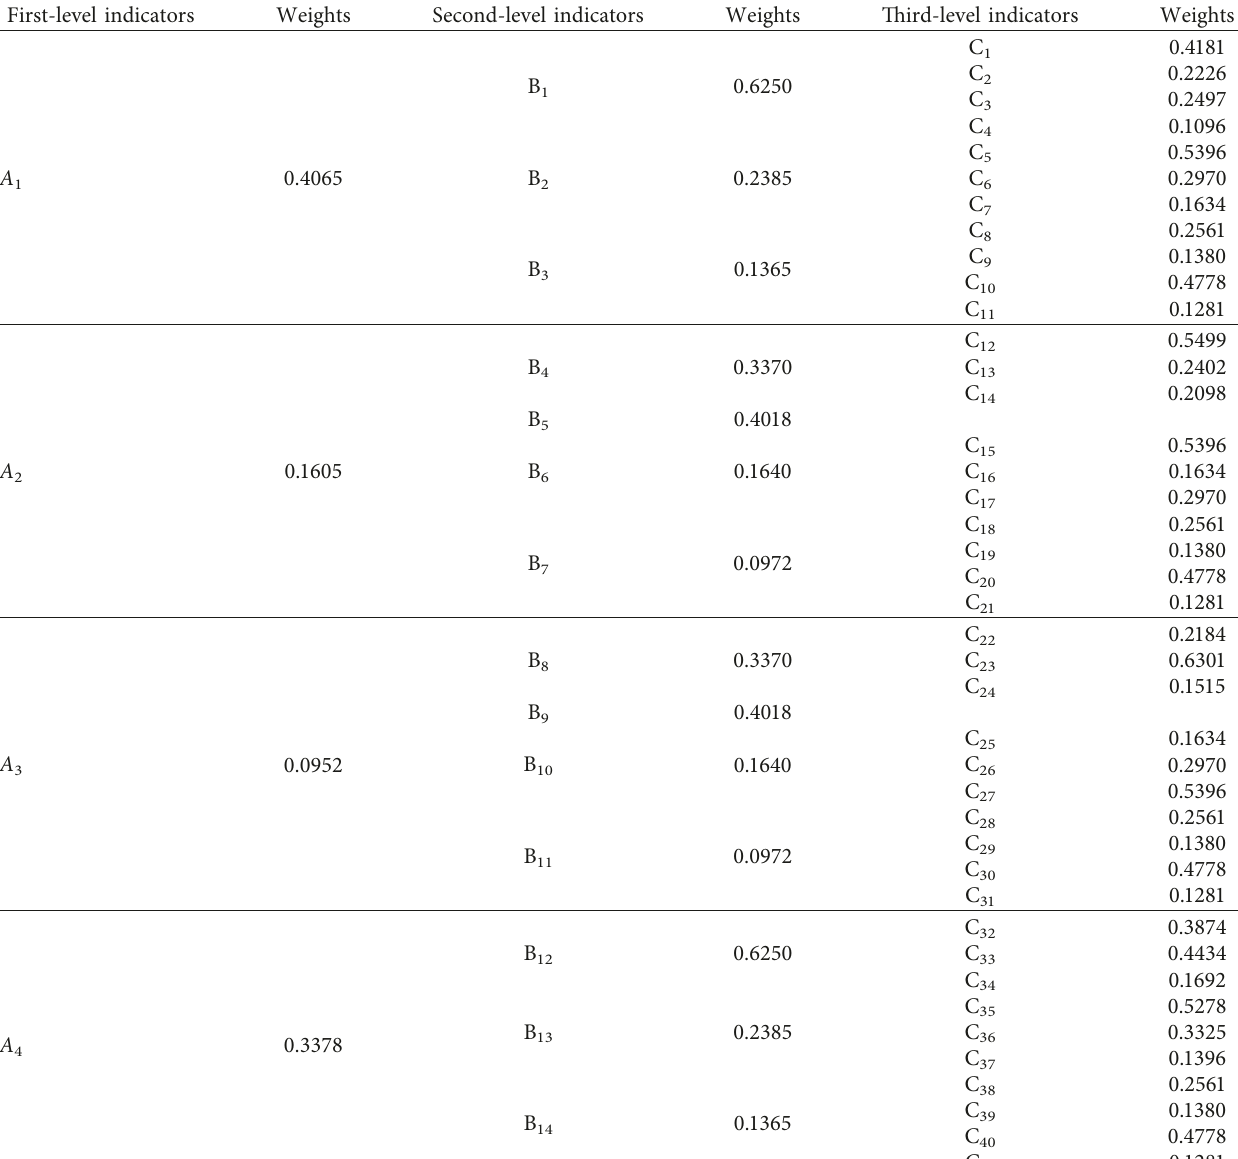
Table 1: Evaluation index weight